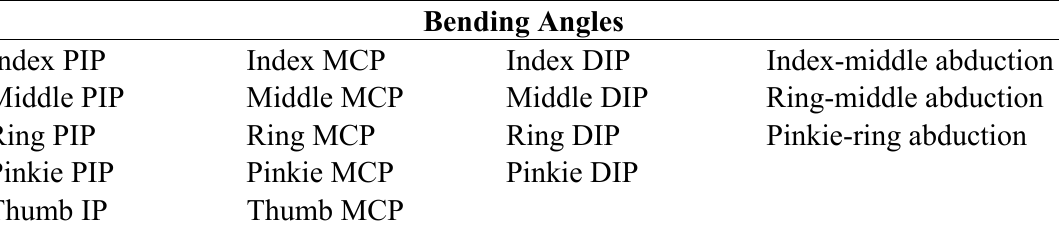
Table 1. The list of seventeen bending angles.